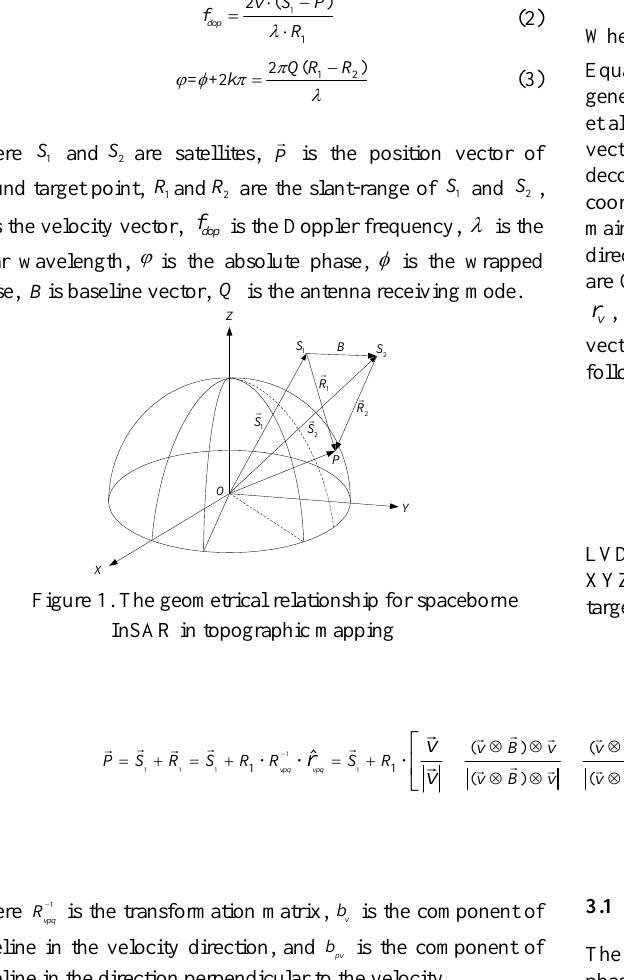
Figure 2, we found that elevation error of about 1.42 caused by phase error of 10°, and with the increase of interferometric phase error, the elevation error increase linearly. If the 1:50000 scale topographic mapping are to be completed, the elevation precision of the hilly area needs to be 5m, and here the effect of the phase error has reached about 28.4%. Therefore, the interferometric phase error is an important error source in the topographic mapping of